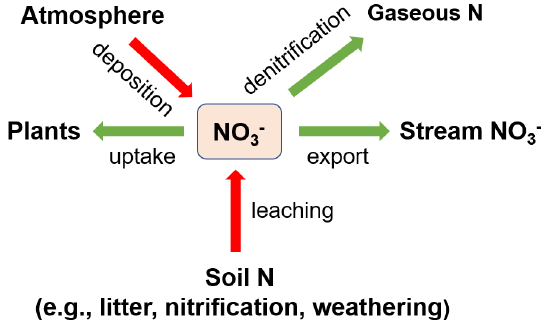
Figure 7. Modeled nitrogen processes in Example 2.